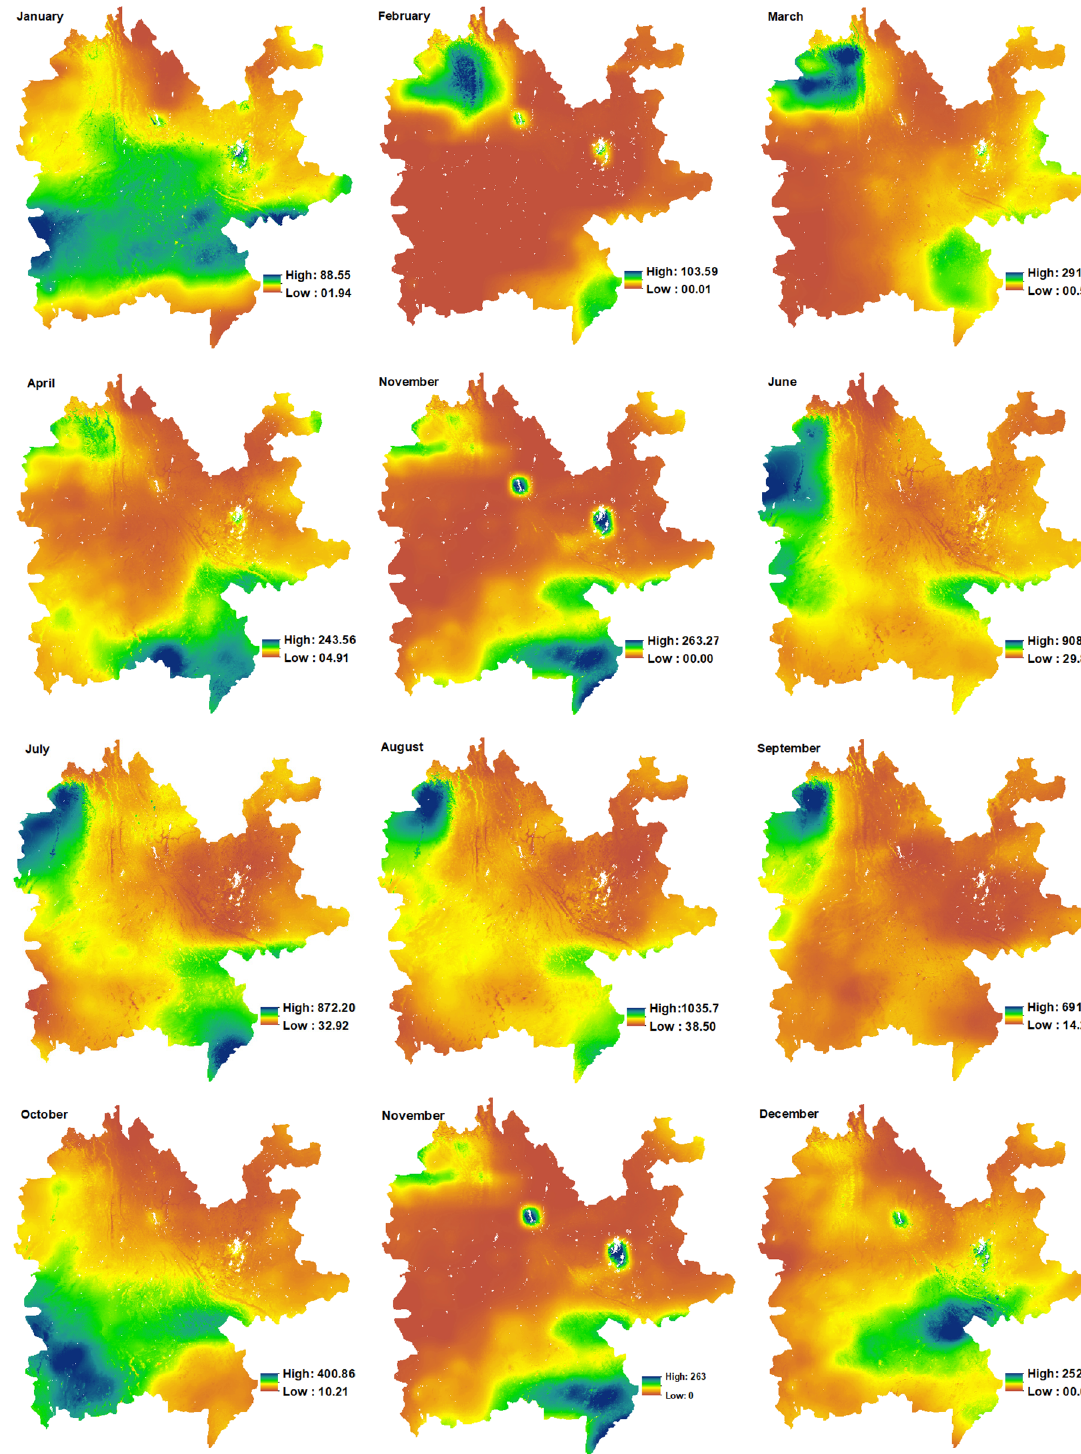
Figure 11. Downscaled monthly TRMM precipitation by disaggregation from January to December Figure11. Downscaled monthlyTRMM precipitationby disaggregation from January to December 2018.